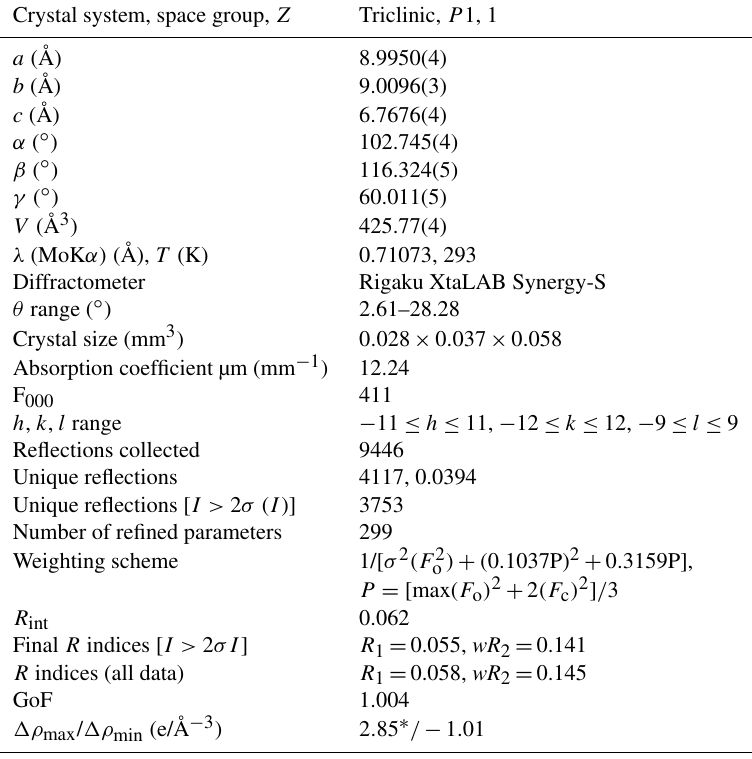
Table 3. Crystal data, data collection information, and structure refinement details for alicewilsonite-(YCe). Crystal system, space group,